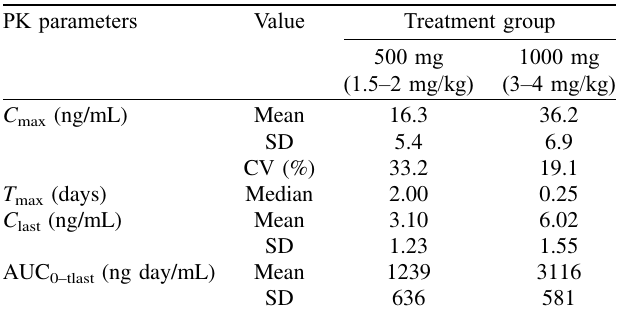
Table 1. Mean pharmacokinetic (PK) parameters in the two groups of animals treated with IVM.